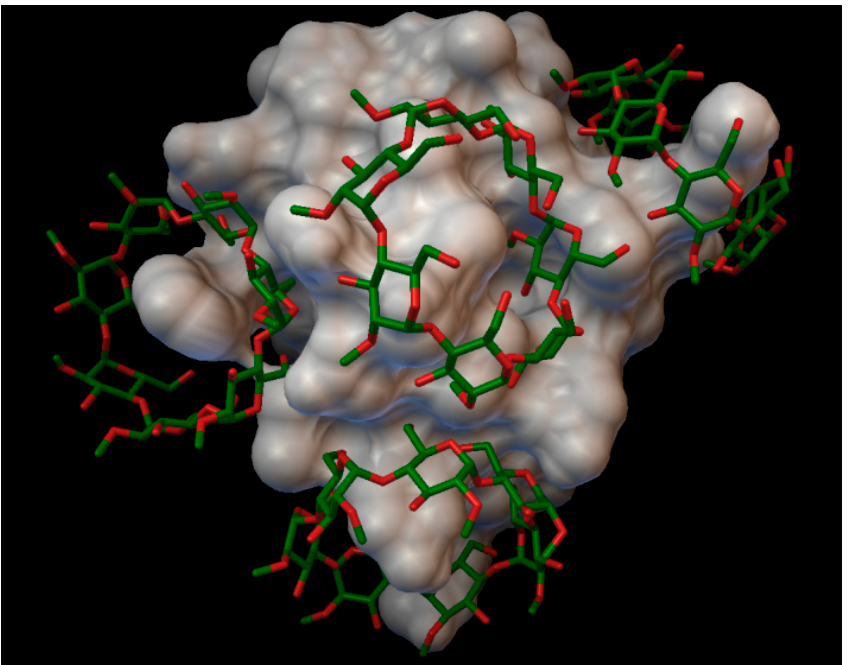
Figure 7. Insulin-methyl- β -cyclodextrin (DS 6) complex. The insulin molecular surface is marked with white and the cyclodextrin molecules are marked with green and red licorice.